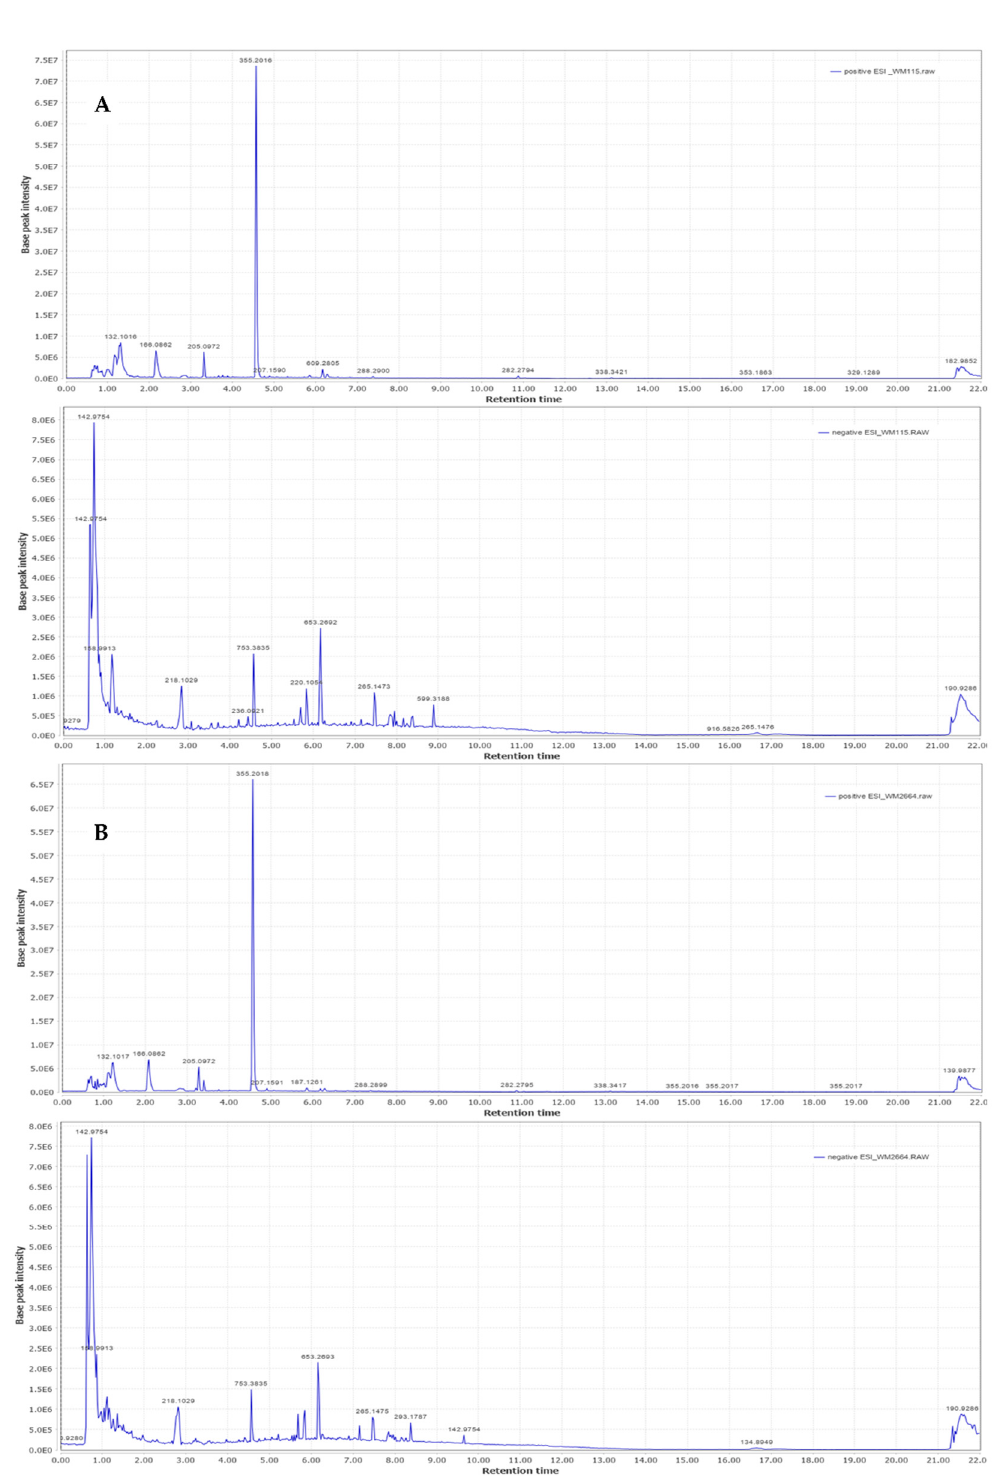
Figure 7. Typical base peak intensity chromatograms of: ( A ) WM115 and ( B ) WM2664 melanoma cells, for positive (upper panels) and negative (bottom panels) ion mode.